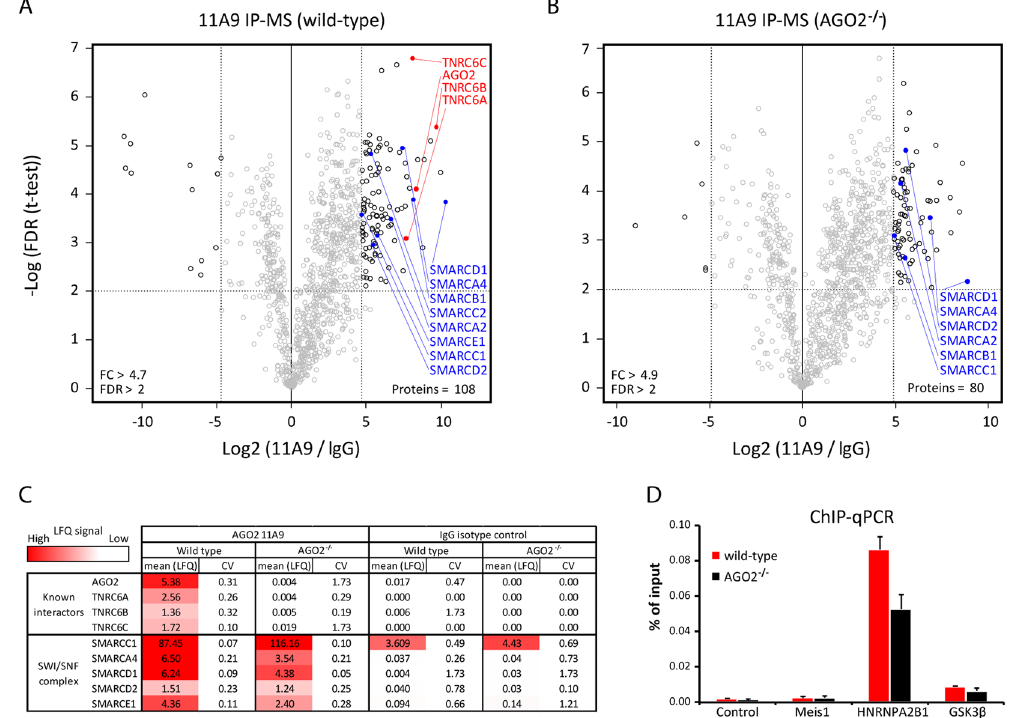
Figure 5. The 11A9 antibody enriches SWI/SNF factors in the absence of AGO2. ( A , B ) Label-free quantification of 11A9 antibody associated proteins compared to IgG isotype control. IP-MS experiments were performed in triplicate in wild type and AGO2 knock-out HEK293T cells. For the analysis a two-sample t-test was applied. ( C ) Table with mean Maxquant derived label free quantification (LFQ) intensities (x10) of 3 IP-MS experiments for 11A9 and IgG with HEK293T wild-type and AGO2 knock-out lysates. AGO2 TRNC6A, B and C signals in AGO2 knock-out extracts are the result form imputation. CV represents coefficient of variation. ( D ) ChIP-qPCR in wild type and knock-out HEK293T cells. The control region (heterochromatic site) and Meis1 locus represent negative